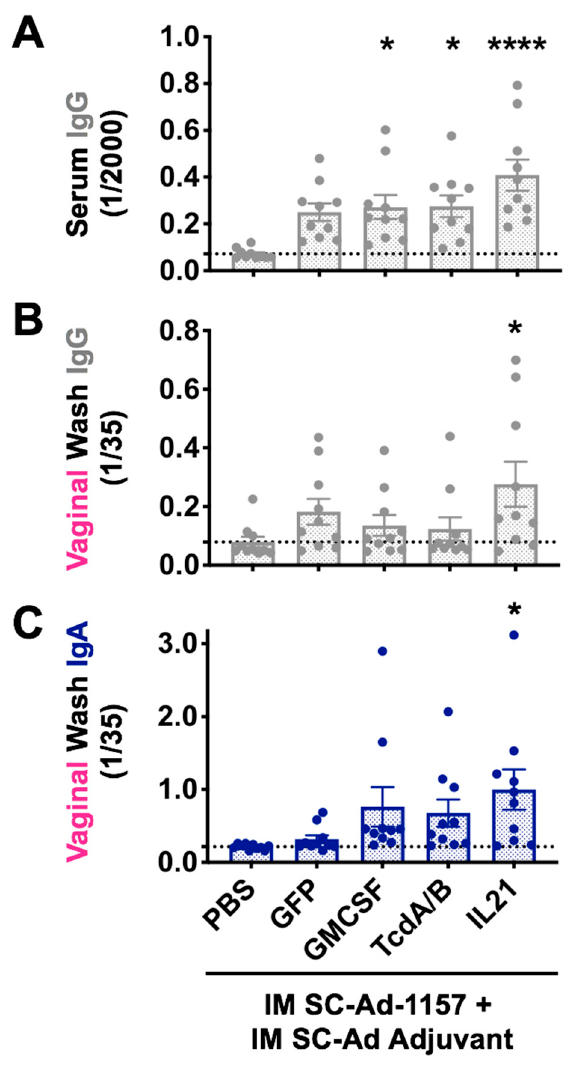
Figure 3. Effects of SC-Ad genetic adjuvants on clade C env antibody responses in mice after intramuscular (IM) immunization. Groups of 10 female BALB/c mice were immunized with PBS or 10 10 vp of the indicated SC-Ads. Six weeks later, samples were collected for ELISA vs. clade C CN54 gp140 ( A ) , ( B ), and ( C ) six week ELISAs after a single high dose IM immunization. Mean +/ − SEM is shown. ( A ) 1/2000 sera dilutions detecting IgG. ( B ) IgG ELISA for 1/35 dilution of vaginal wash samples. ( C ) IgA ELISA for 1/35 dilution of vaginal wash samples. * p < 0.05, **** p < 0.001 by one-way